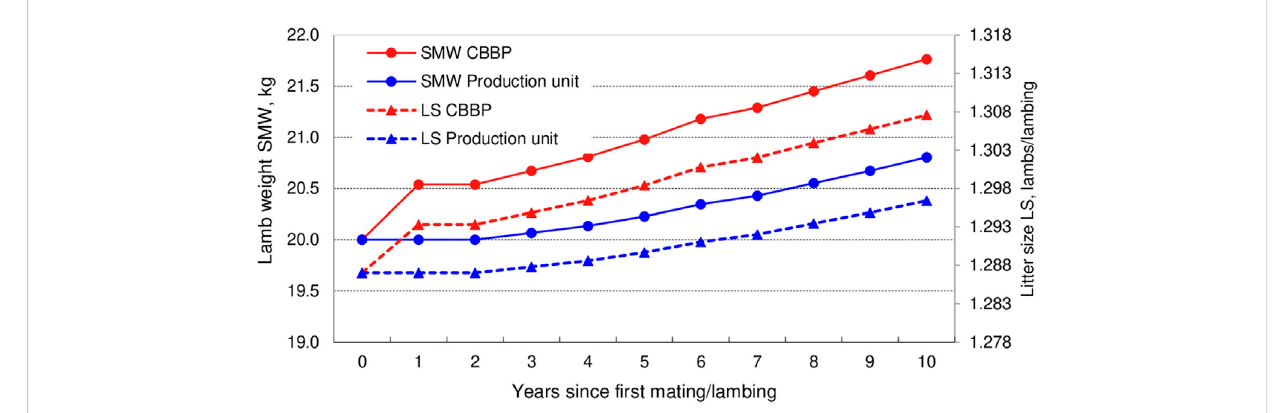
FIGURE 2 Genetic progress of lamb weights (SMW) and litter size (LS) in CBBPs and client production units starting selecion in year) and assuming no initial genetic differences between CBBPs and production units.